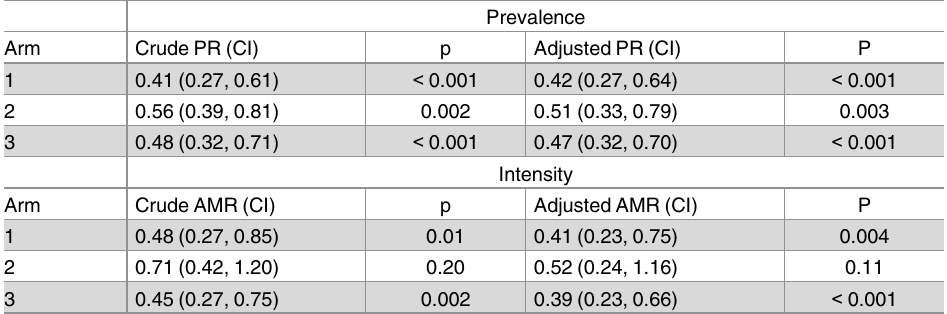
Table 2. Comparisons of change in 9–12 year old prevalence and intensity of S . mansoni infection between year 1 and year 5 for each arm, 25 villages per arm. Adjustment of PRs and AMRs are for age, sex, and villagesample size.